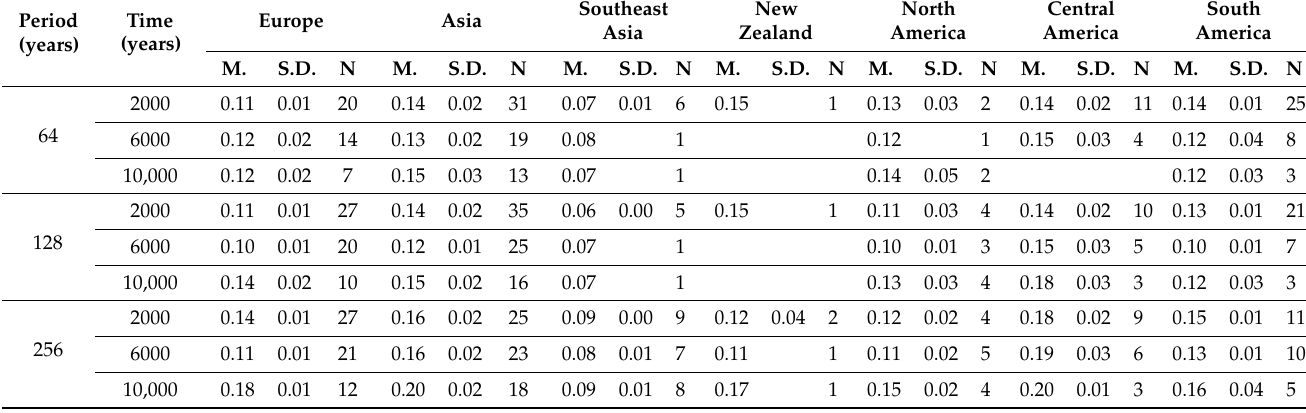
Table 1. For every subharmonic mode, variations in the δ 18 O composition in speleothems (per mil) representing the am ‐ plitude of rainfall oscillation averaged over the speleothems representative for each region (M), the standard deviation of the mean (S.D.), and the number of speleothems (N).